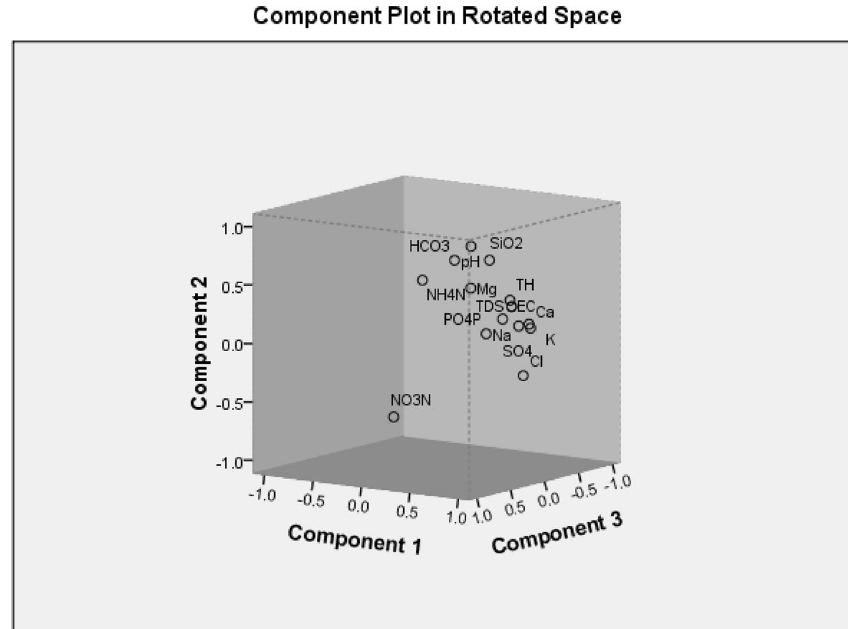
Fig. 13 Component plot in rotated